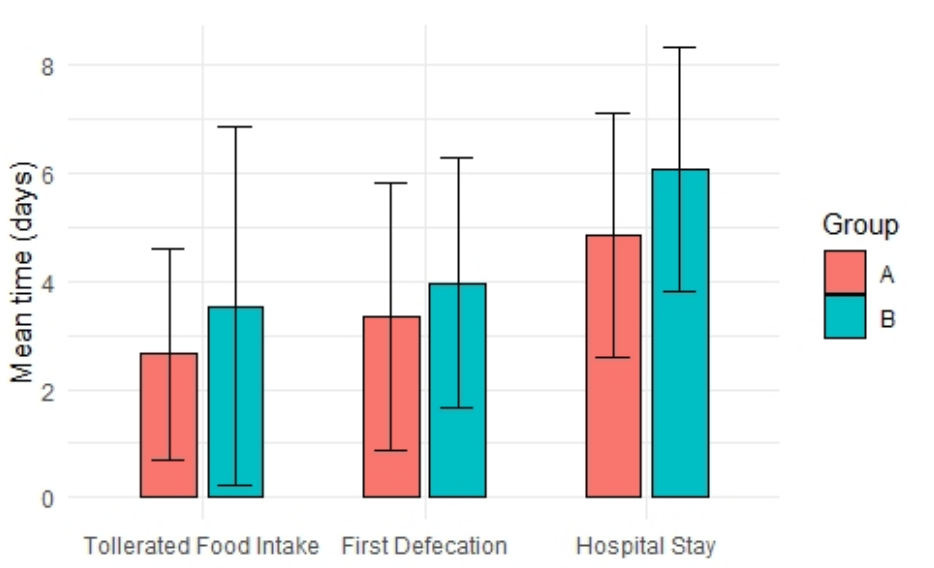
Figure 2. Tolerated food intake, first defecation and Length of Stay (LOS) comparison between groups. Table 5. Results of primary and secondary outcomes.